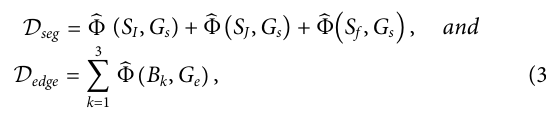
Frontiers in Molecular Biosciences |